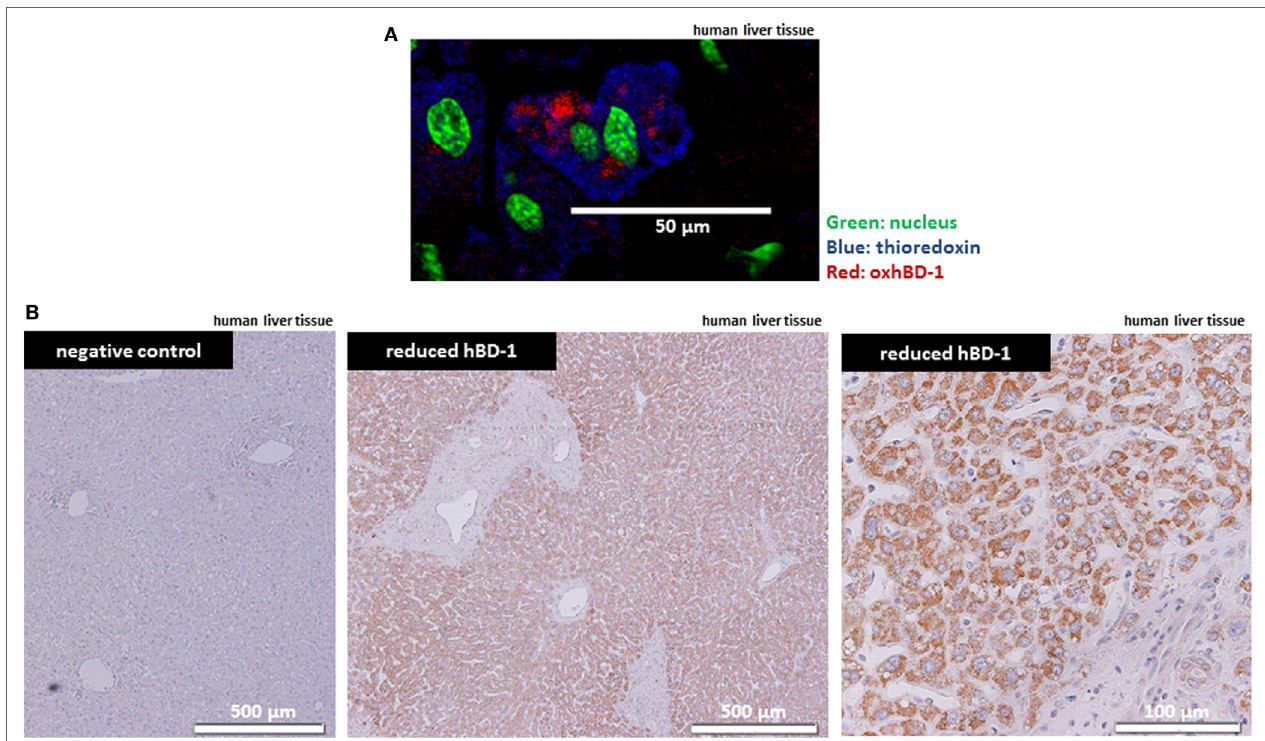
FigUre 2 | Antimicrobial active—reduced hBD-1—is strongly expressed in human hepatocytes. (a) Liver tissue from a representative healthy person was stained for TRX (blue) and oxidized hBD-1 (red), showing hBD-1 and TXN being co-localized in human hepatocytes. Nuclear staining is depicted in green. (B) Staining of reduced hBD-1 shows a strong and ubiquitous expression of reduced hBD-1 in human liver